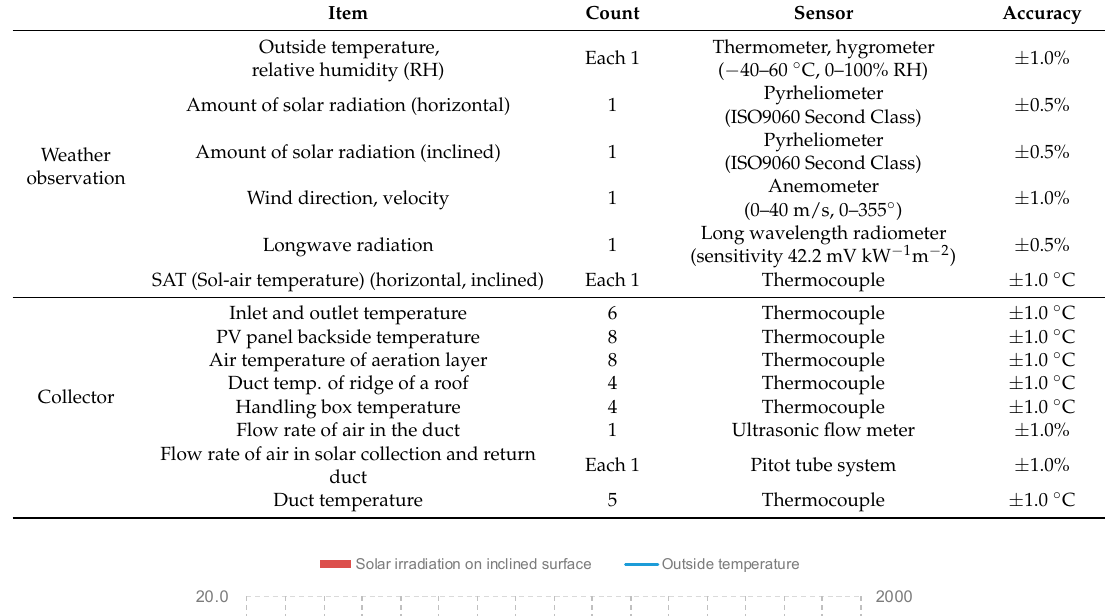
Table 6. Measurement equipment.